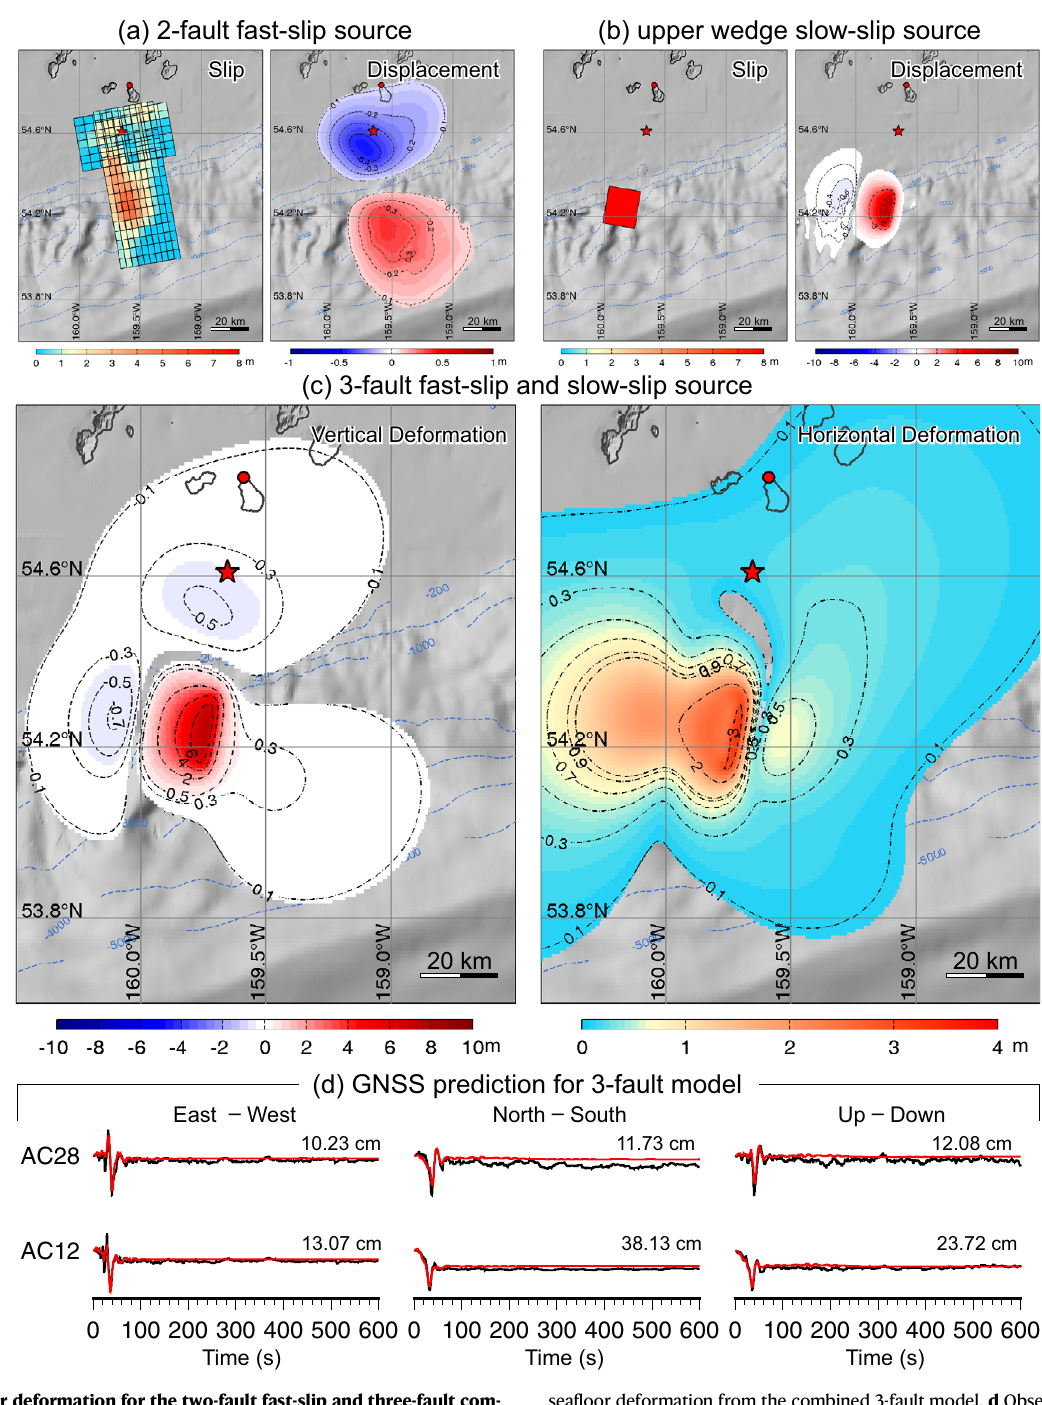
sea fl oor deformation from the combined 3-fault model. d Observed (black) and computed(red)GNSSgroundmotionsforstationsAC28andAC12extendingovera 600s time scale. Tsunami predictions for this model are shown in Fig. 8. Red star indicates the epicenter, and the red circle denotes the GNSS station